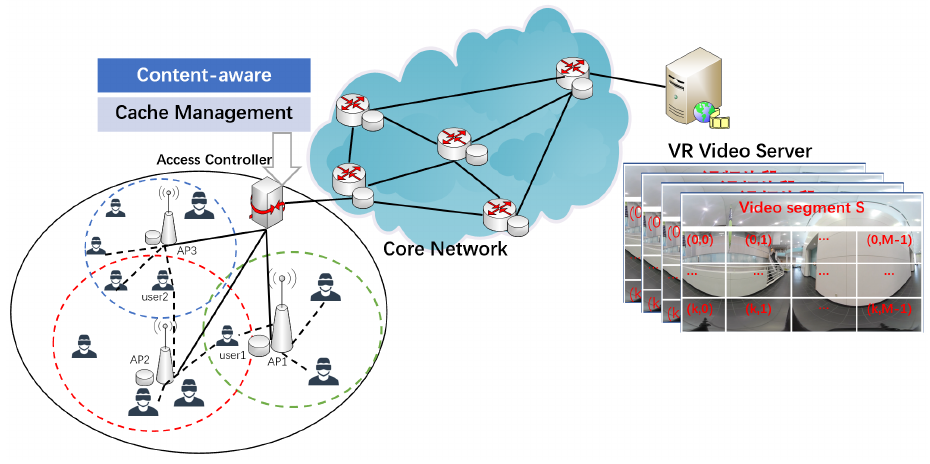
Figure 1. System